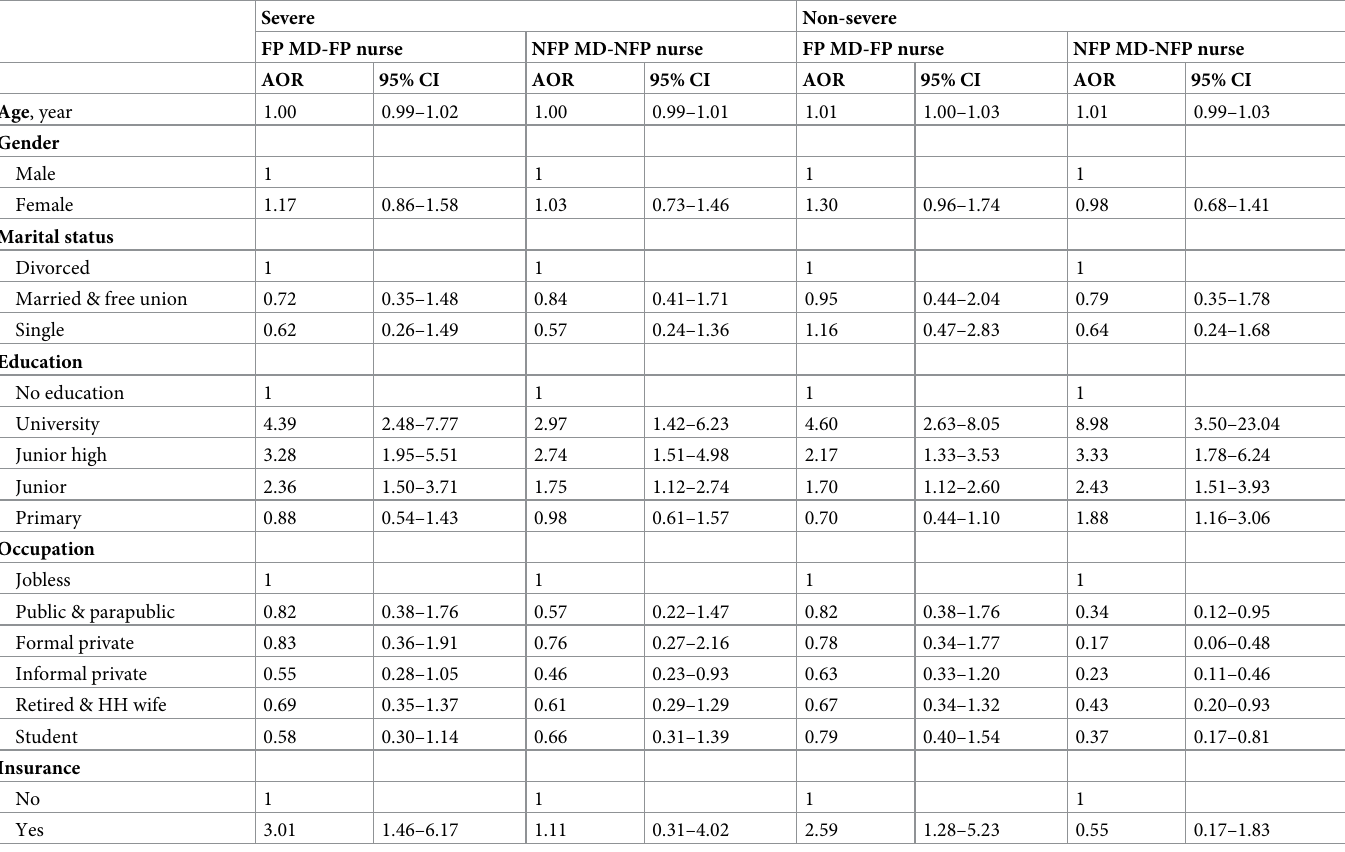
Table 2. Multivariable logistic regression of private healthcare utilization by severity of condition and providers’ qualification (MD and